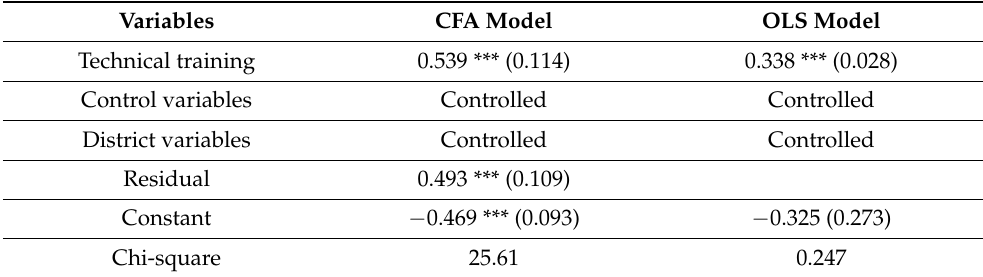
Table 4. Estimates of the CFA model and OLS